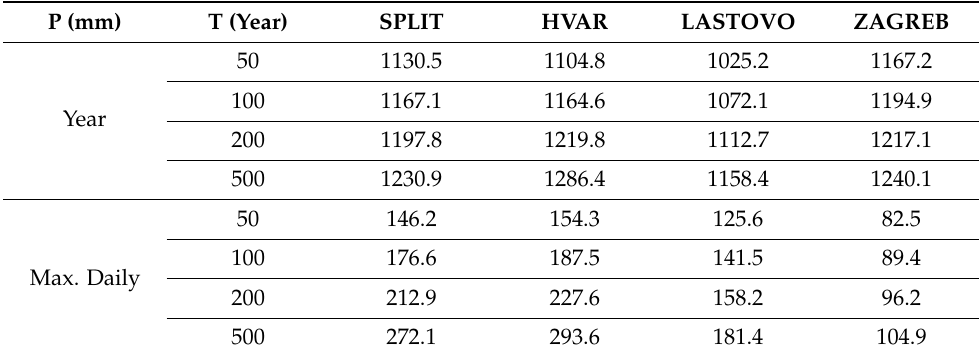
Table 3. Matrix of precipitations, P (mm), and their return periods, T (year), calculated for the four analysed stations time series of whole annual and maximum annual daily precipitations (1948–2020) using GEV distribution.